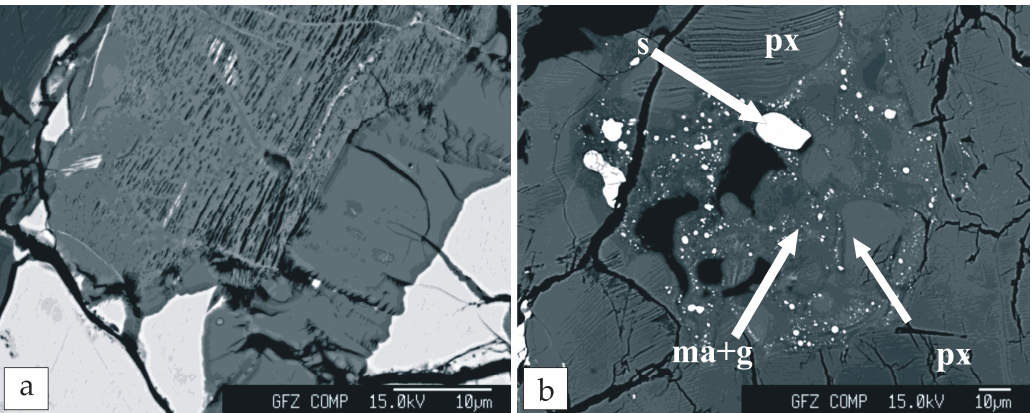
Figure 3. Phase relationships: ( a ) Pyroxene with melting/dissolution textures; and ( b ) multi-phase pockets. Abbreviations: ma+g, maskelynite and glass; px, pyroxene; s, sulfides.